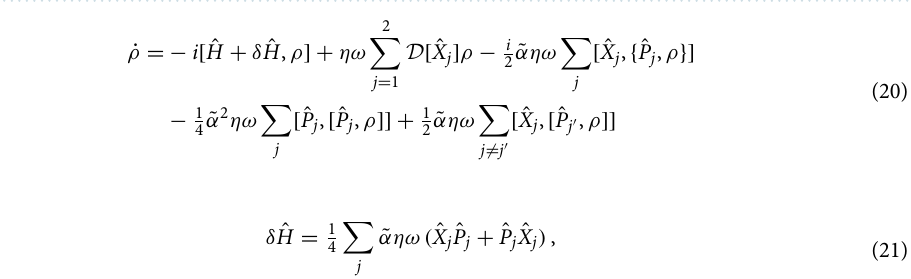
0 (standard KTM model) is also displayed for comparison. ( b ): Asymptotic α ˜ =